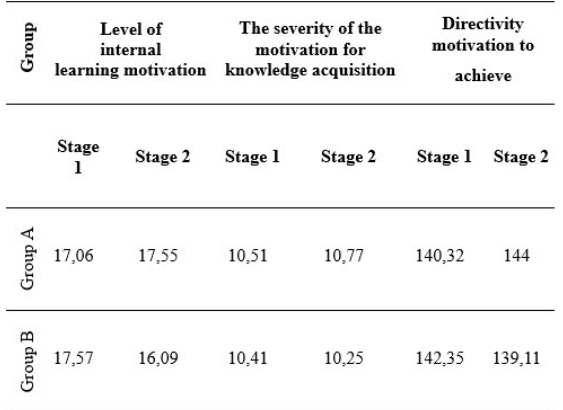
Table 2. Comparison the results of ascertaining and control experiment in the groups of distance and full-time intellectually gifted